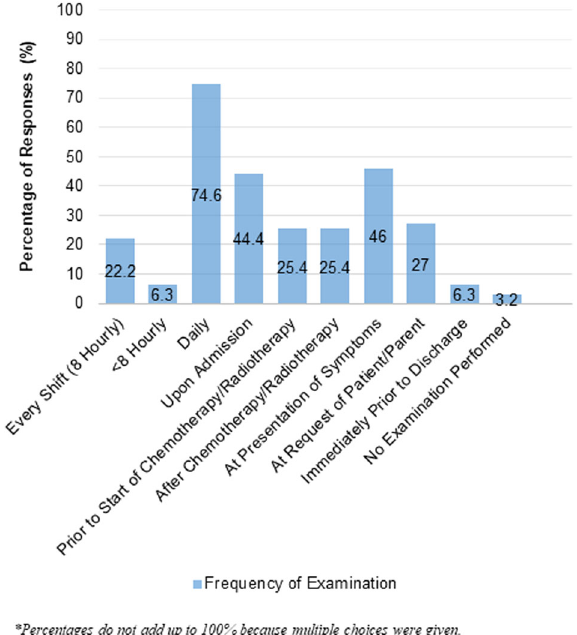
Fig. 1 Frequency of oral examination by